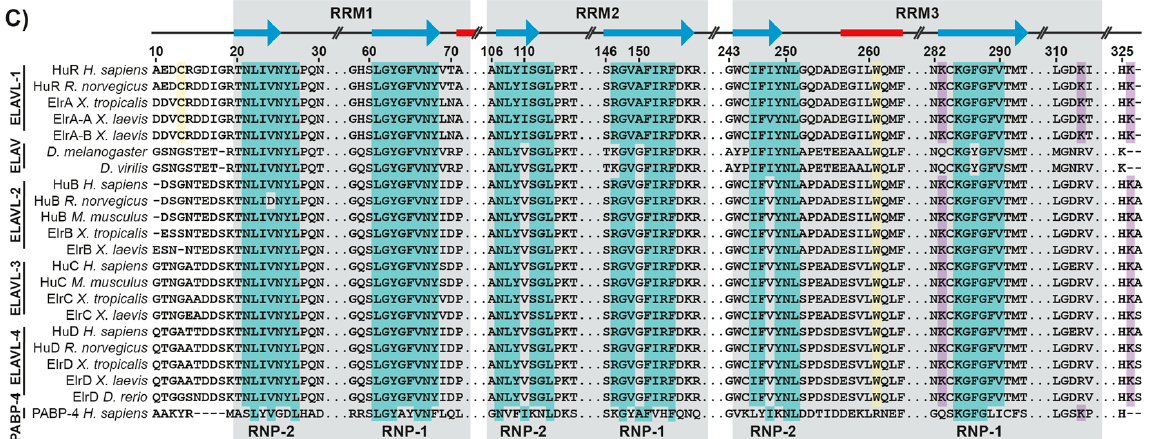
Figure 1. HuR domain organization, structures, and sequence alignment. ( A ) Schematic domain organization of human HuR. Black numbers indicate the residues flanking each domain. RNPs and residues flanking RNPs are colored in cyan. C13 and W261, implicated in dimerization, are highlighted in yellow. Susceptible lysines to become NEDDylated are highlighted in purple. N and C indicate N-terminal and C-terminal endings, respectively. ( B ) Ribbon structures of human HuR RRM domains. Side-chains of residues at RNPs are colored in cyan, those of C13 and W261 are highlighted in yellow; NEDDylated lysines are shown in purple. β -strands and α -helixes numbers are indicated. Left panel: NMR structure of RRM1 domain. Ten models are shown (PDB: 5SZW) [14]. Middle panel: X-ray structure of RRM12 tandem of HuR (PDB: 4ED5) [5]. Right panel: X-ray structure of RRM3 domain, in its dimeric form (PDB: 6GD1) [15]. ( C ) Sequence alignment of HuR, with homologous RNA binding proteins (ELAV, ELAVL-1, ELAVL-2, ELAVL-3, ELAVL-4, and PABP-4), from human and related organisms. Residues belonging to each RRM domain are shaded in grey. RNPs residues from HuR are highlighted in cyan, whereas C13 and W261 are in yellow. K283, K313, and K326 are highlighted in purple. Blue arrows represent β -strands, and red rectangles represent α -helixes of